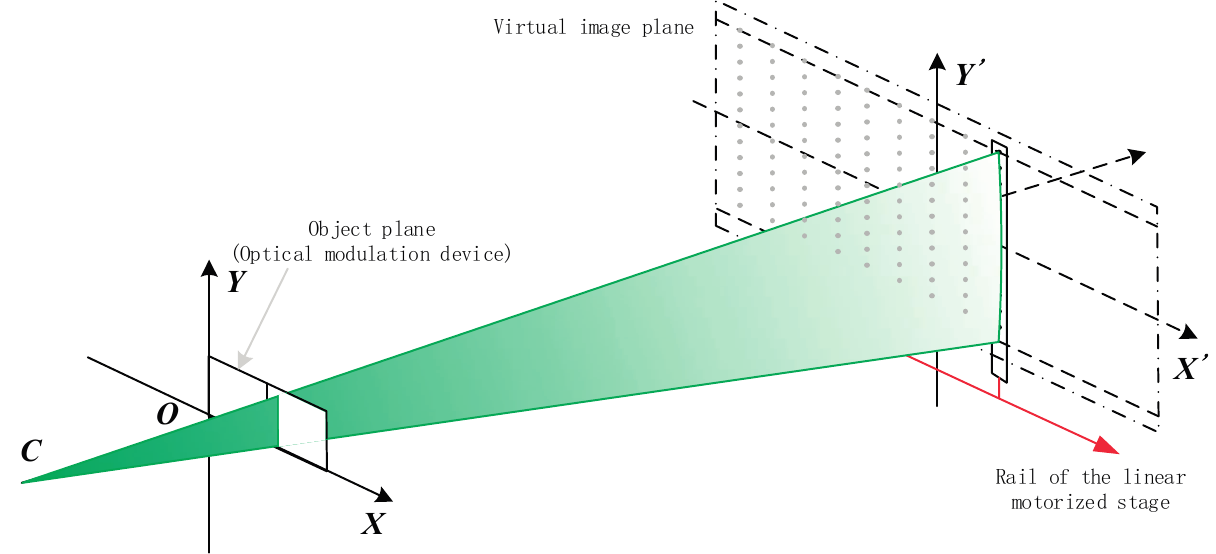
Figure 1. Geometry model of calibration system. The solid square on plane XOY indicates the position of the optical modulator. Point C indicates the optical center and the line COO’ indicates the primary optical axis of the projector in pinhole model. The dashed square on plane O’X’Y’ indicates the motive track of the photoelectric target. The gray points on plane O’X’Y’ are